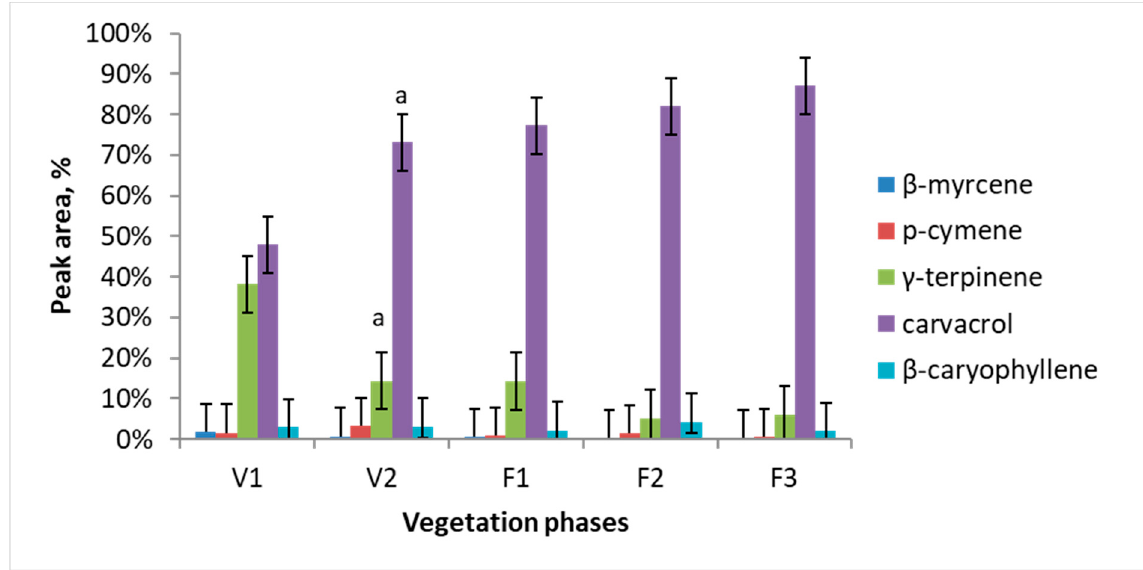
Figure 1. Dynamics of essential oil major components of Satureja hortensis L. during the vegetation determined using gas chromatography—mass spectrometry. Vegetation phases: V1—intensive growth, V2—budding, F1—beginning of flowering, F2—massive flowering, F3—end of flowering. Mean values ± SD from three independent experiments are presented. a statistically significant differences versus V1, ( p < 0.05).